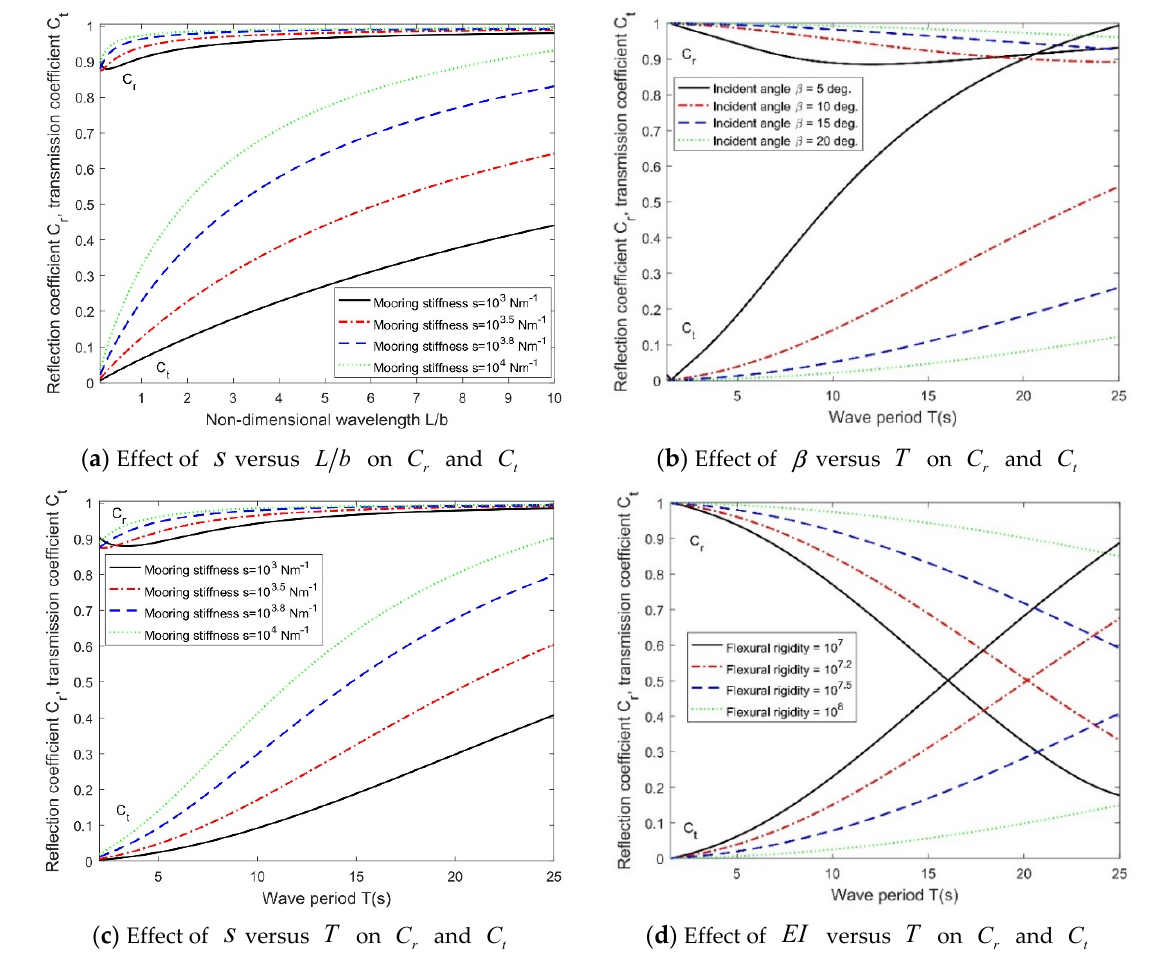
Figure 9. Effects of ( a ) mooring stiffness versus non-dimensional wavelength, ( b ) incidence angle, ( c ) mooring stiffness, and ( d ) flexural rigidity versus wave period on the C r and C t for EI = 10 5 , (cid:96) = 1.5